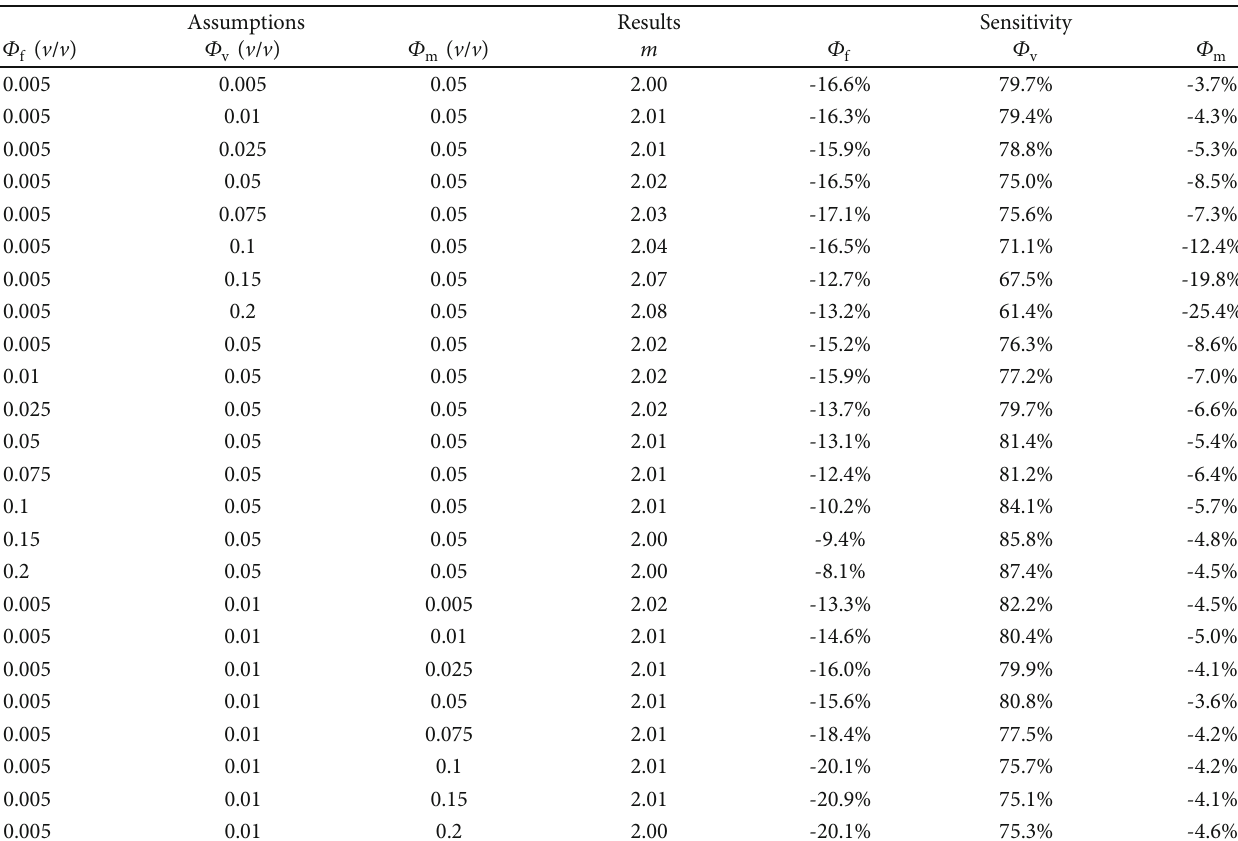
Table 1: m values of the triple-porosity media reservoir at various combinations of matrix porosity, fracture porosity, and nonconnected vug porosity.